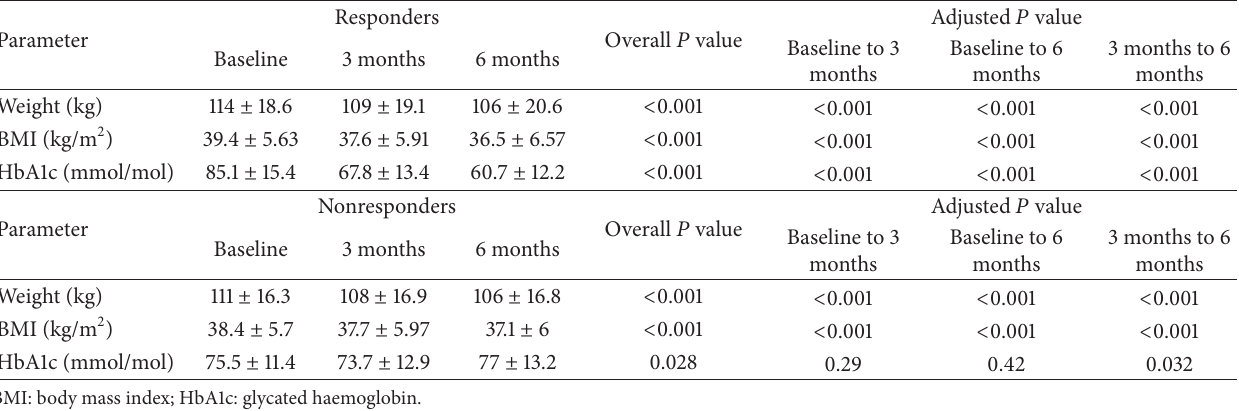
Table 2: Mean ( ± SD) weight, BMI, and HbA1c at baseline, 3 months, and 6 months within responders ( 𝑛 = 63) and nonresponders ( 𝑛 = 49). The overall 𝑃 value reflects the significance before adjustment and adjusted 𝑃 value denotes the significance between time points following Tukey’s test for multiple comparisons.